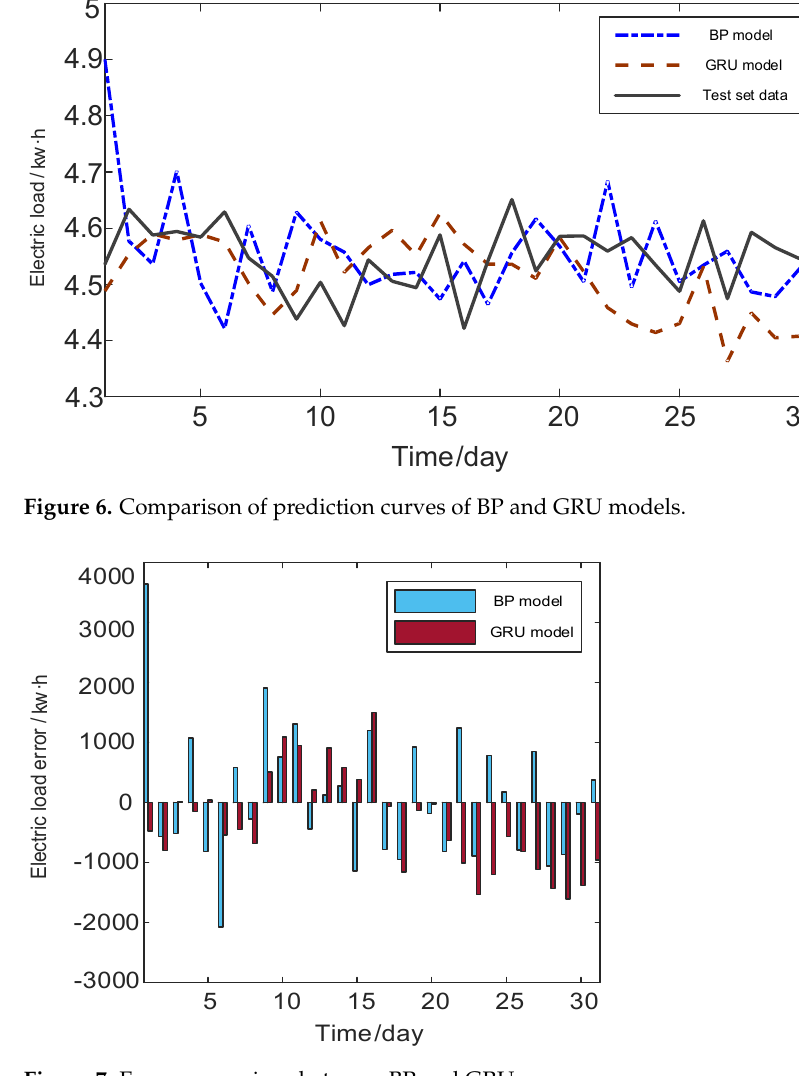
Figure 7. Error comparison between BP and GRU.